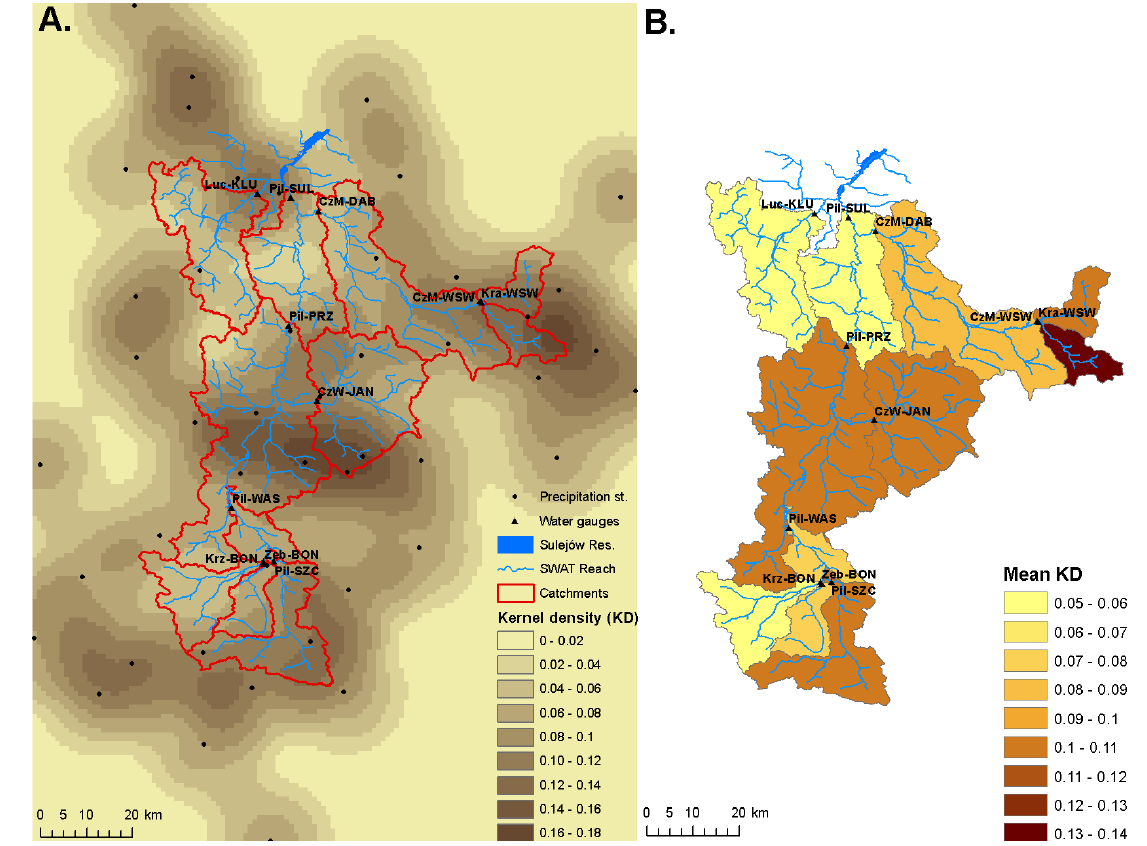
Figure 3. A surface of kernel density function ( A ) applied for estimation of station density within each catchment ( B ) expressed in units (number of stations) per km 2